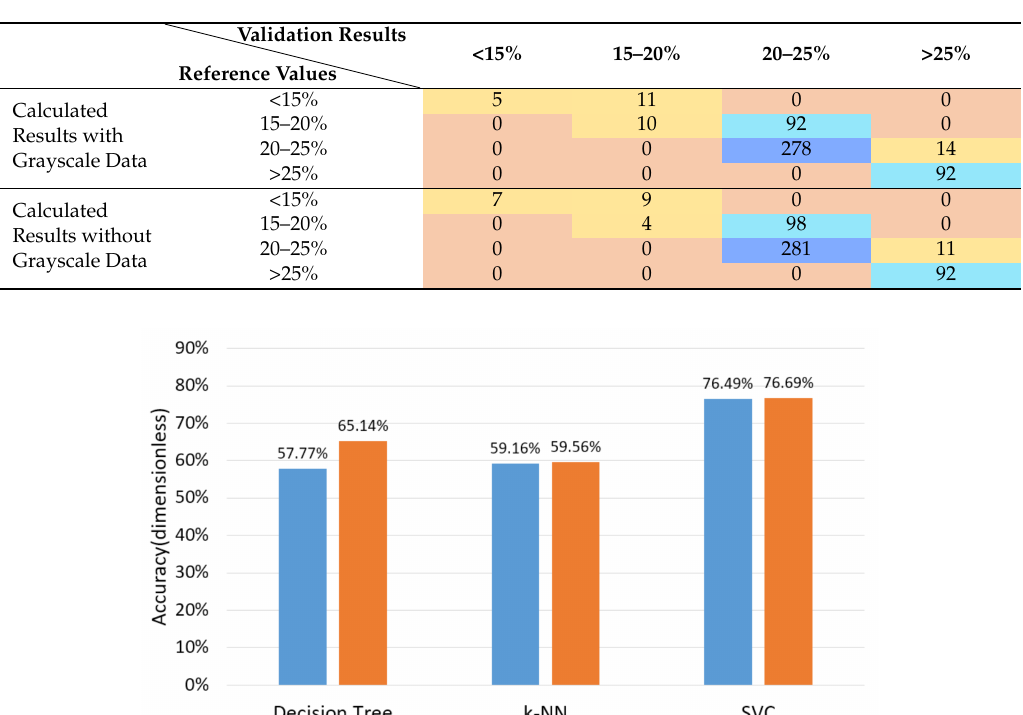
Table 1. The validation set with (or without) grayscale data and its calculated results by SVC.